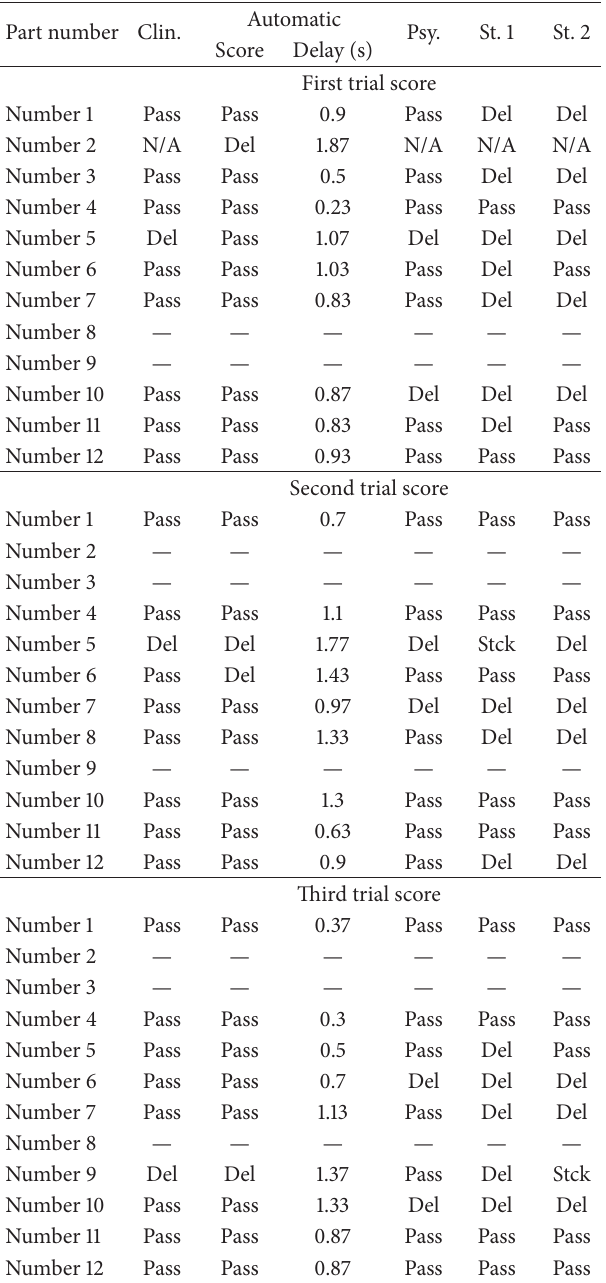
Table 2: Results of Disengagement of Attention task. Scores from the clinician (Clin.), automatic method (Automatic), a psychiatrist (Psy.), and two students (St. 1 and St. 2) for each trial. A trial is considered either as “passed” (Pass), “delayed” (Del), or “stuck” (Stck) depending on whether the child disengages from the first object in less than 1s, between 1 and 2s, or more than 2 s, respectively. We also present the automatically computed delay that the child takes to disengage. Note that we consider 𝑎 + (1/3) of a second margin for each delay to accommodate human error of making a live